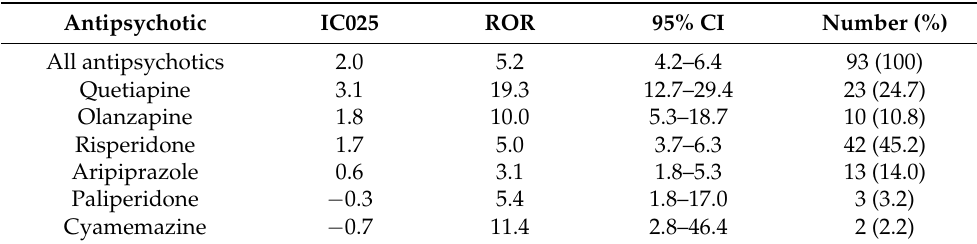
Table 4. Disproportionality analysis for reports of abuse, dependence, or withdrawal in patients aged between 2 years and 11 years, ranked by